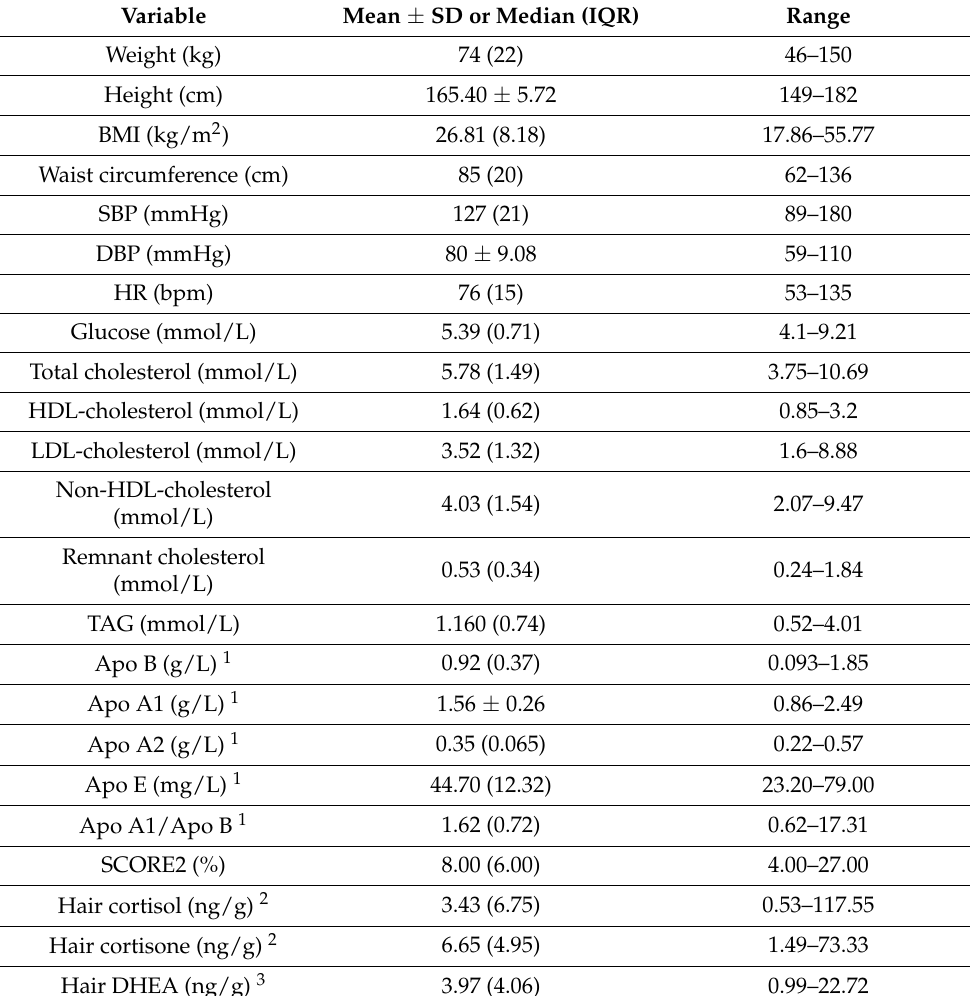
Table 3. Anthropometric indicators, glucose and lipid metabolism biomarkers as well as hair steroid hormone levels of the study